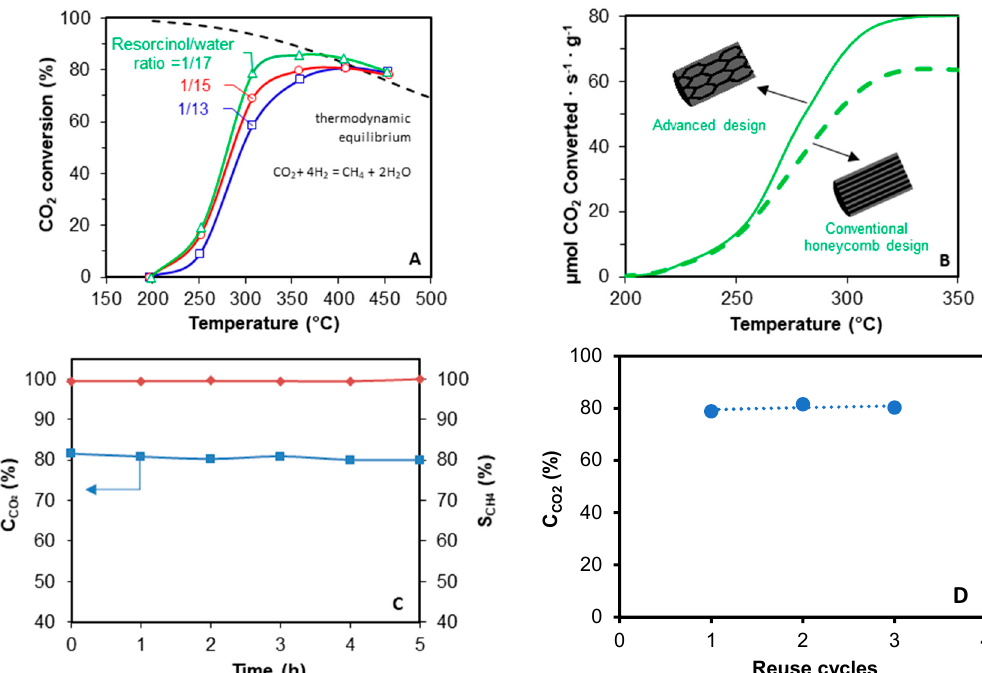
Figure 6. CO 2 methanation tests over Ni/CeO 2 /carbon monolith catalysts prepared using 3D printing. ( A ) Influence of the porous texture of monoliths with conventional design on the catalytic performance. ( B ) Influence of the channels configuration on the CO 2 methanation reaction rate; both monoliths were prepared with resorcinol/water ratio = 1/17. ( C ) Isothermal test at 300 ◦ C for the catalyst with advanced design prepared with resorcinol/water ratio =1/17. C CO2 = CO 2 conversion and S CH4 = Selectivity to methane. ( D ) Study of the stability of the catalysts after being reused in successive cycles. C CO2 : conversion of CO 2 at 300 ◦ C.